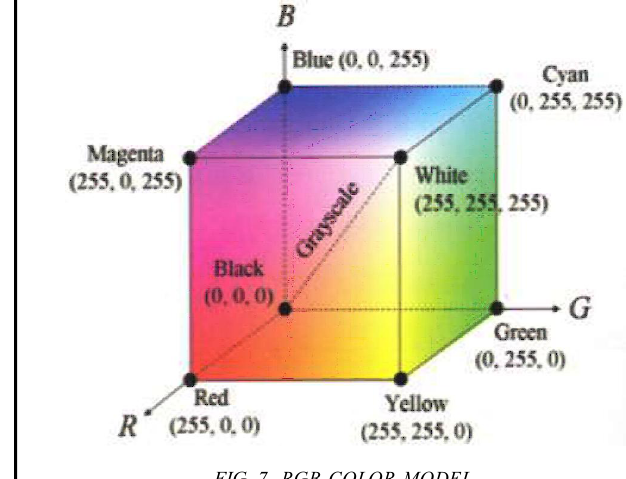
FIG. 6. FLOW CHART OF VISION PROCESS FIG. 7. RGB COLOR